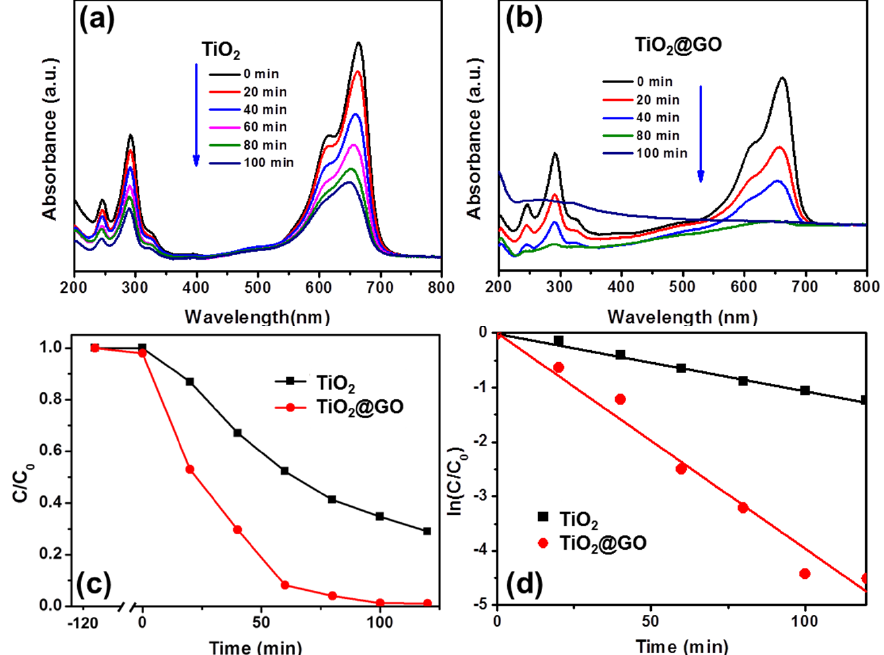
Figure 4. Methylene blue decomposition by ( a ) TiO 2 and ( b ) TiO 2 @GO with the illumination of visible light; ( c ) Comparison of photocatalytic activities of TiO 2 and TiO 2 @GO; ( d ) Dependence of ln(C/C 0 ) on time.